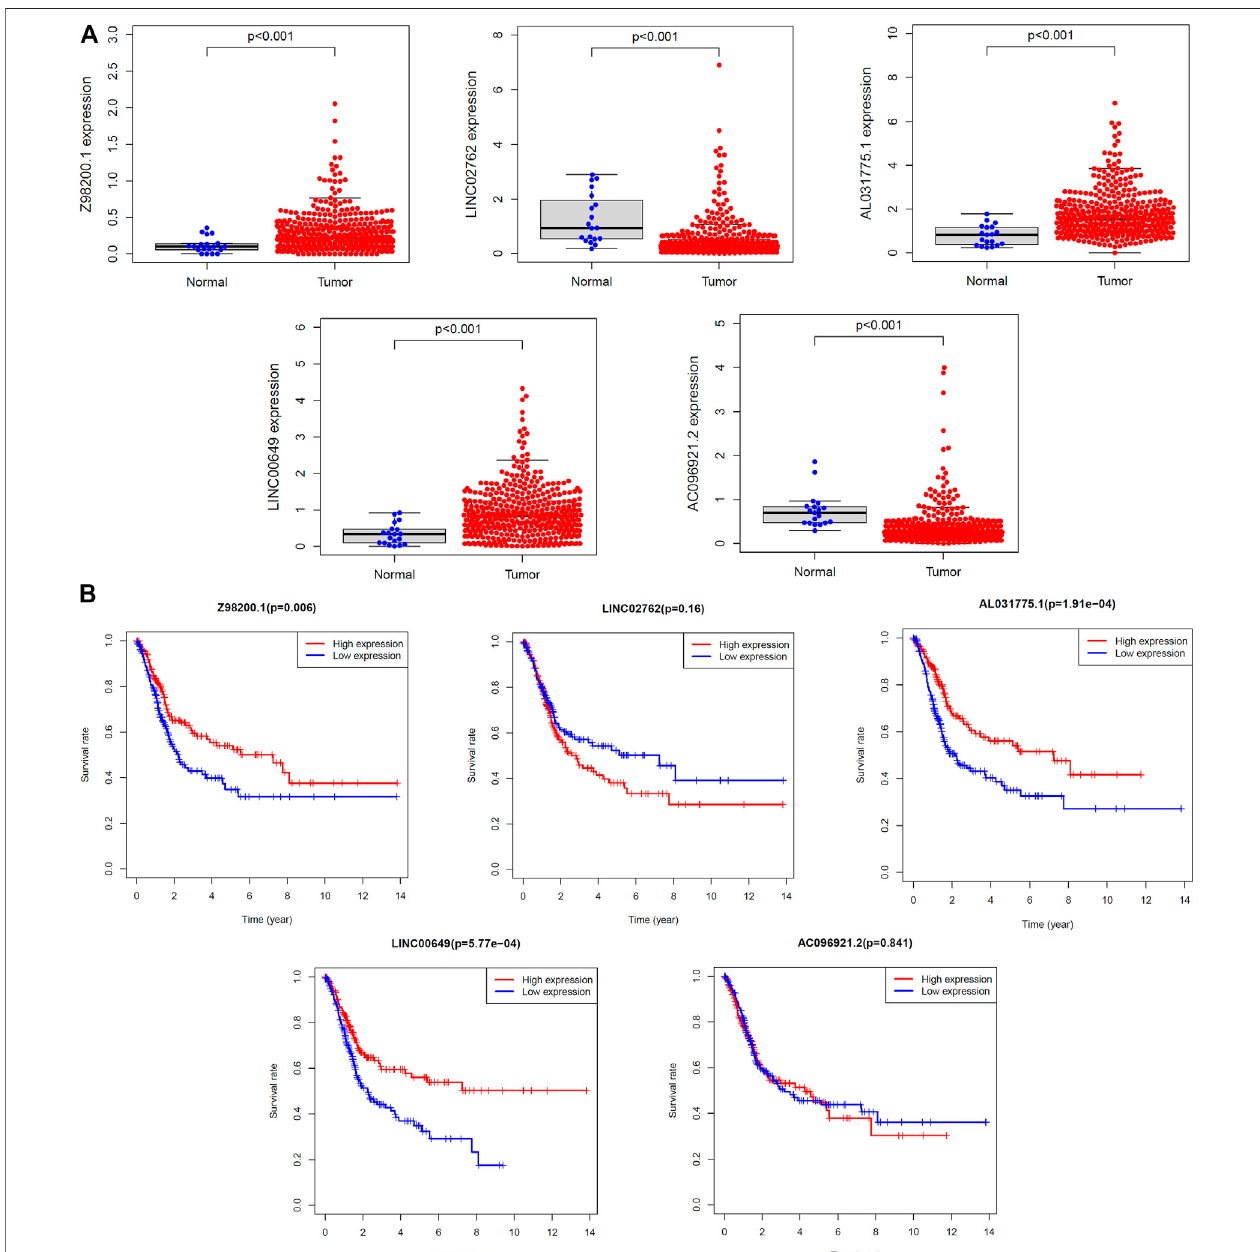
FIGURE 10 | Survival analysis of single lncRNA. (A) The expression levels of fi ve target lncRNAs in tumor tissues and normal tissues were compared. (B) The samples were grouped according to the median expression size for survival analysis, and the survival analysis was carried out.